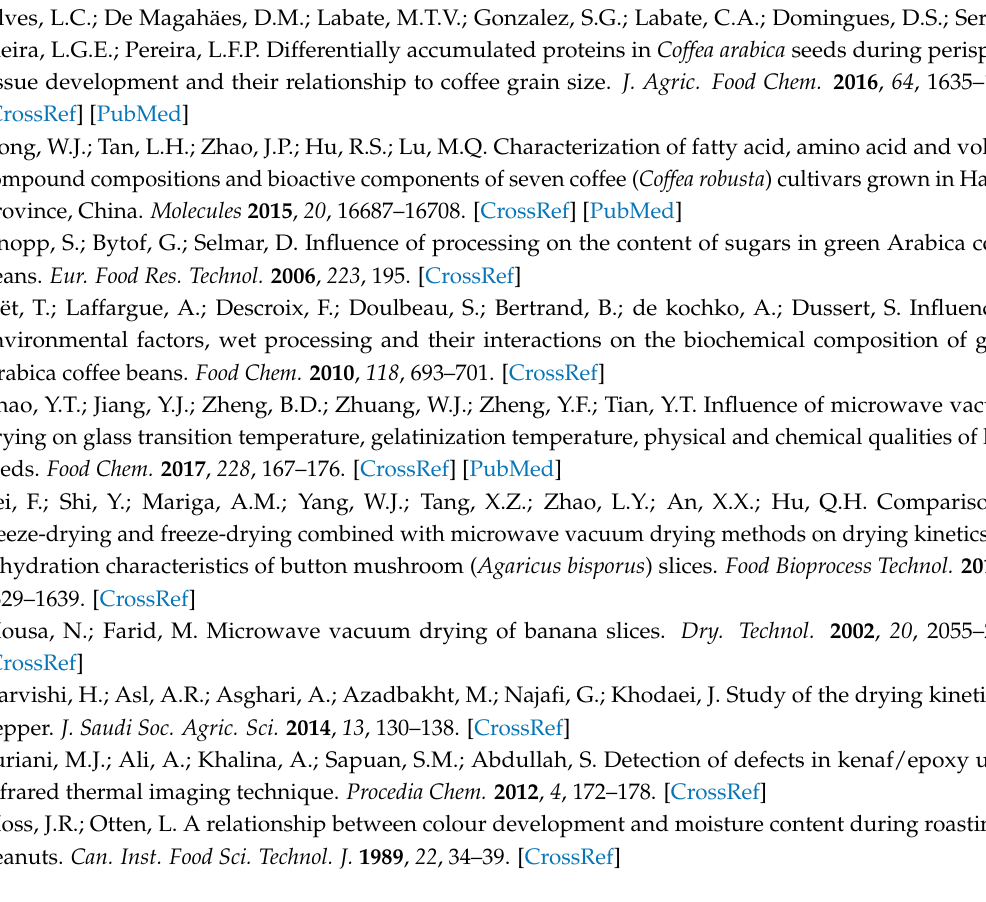
Supplementary Materials: The following are available online, Figure S1: DSC spectra of coffee beans dried at five different microwave power settings. Figure S2: NMR imaging of samples at six stages of the drying process at 1.0-kW microwave power: (a) 0 min; (b) 15.0 min; (c) 30.0 min; (d) 45.0 min; (e) 60.0 min; and (f) 75.0 min. Figure S3: Infrared thermal imaging of samples at eight stages of the drying process at 1.0 kW microwave power: (a) 0 min; (b) 10.0 min; (c) 20.0 min; (d) 30.0 min; (e) 40.0 min; (f) 50.0 min; (g) 60.0 min; and (h) 75.0 min. Table S1: Statistical analyses of modelling of the moisture ratio and drying time during MVD. Table S2: Peak area ratios for the three states of water. Table S3: The Person correlation coefficients for different chemical properties of microwave-dried coffee beans. Table S4: Ten thin-layer drying models used for experimental data fitting [33–38]. Author Contributions: W.D., J.Z. conceived and designed research; K.C., R.H., Y.L. performed research and analyzed the data; W.D. and K.C. wrote the paper; Z.C. performed research and contributed materials. All authors read and approved the final